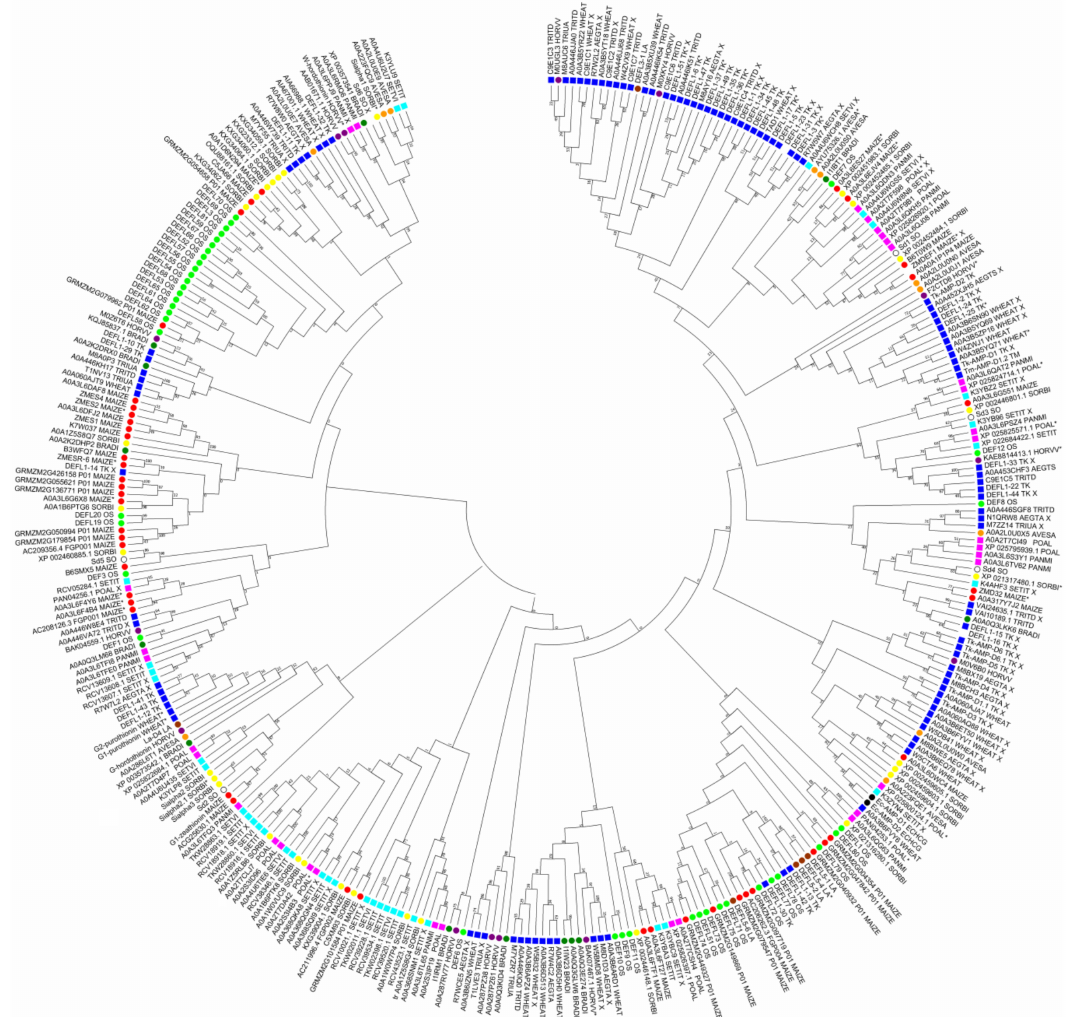
Figure 3. A phylogenetic tree of the grass defensins and defensin-like (DEFL) peptides. The amino acid sequences of the mature DEFLs were used for the phylogenetic tree construction with the MEGA X software [88]. DEFLs of Triticum spp. and Aegilops tauschii are marked with blue squares, while those of Panicum spp. and Setaria spp. are marked with pink and cyan squares, respectively. DEFLs of O. sativa are marked with light green circles, Z. mays with red, Sorghum bicolor with yellow, H. vulgare with violet, Avena sativa with orange, B. distachyon with green, L. arenarius with brown, E. crus-galli with black, and Saccharum spp. with white circles. The following abbreviations are